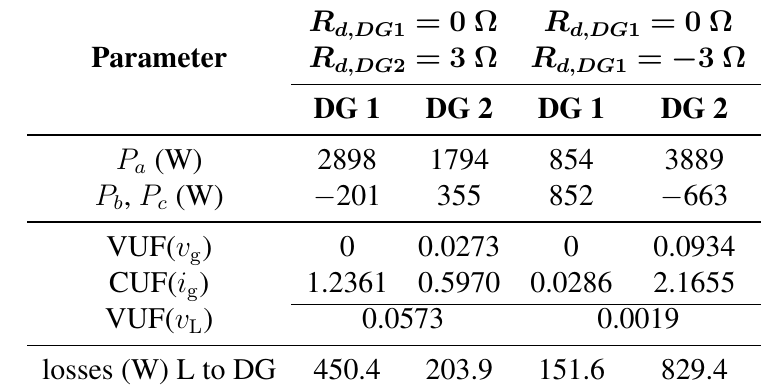
Table 8. Islanded microgrid: power sharing between two DG units with different R = 3 Ω ; R = 0 Ω ( R d l v